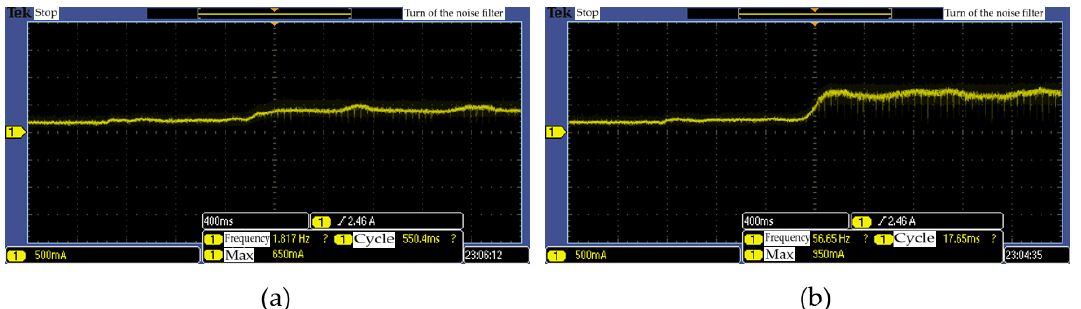
Figure 23. Current value of cylinder grasping: ( a ) torque min, ( b ) torque max.